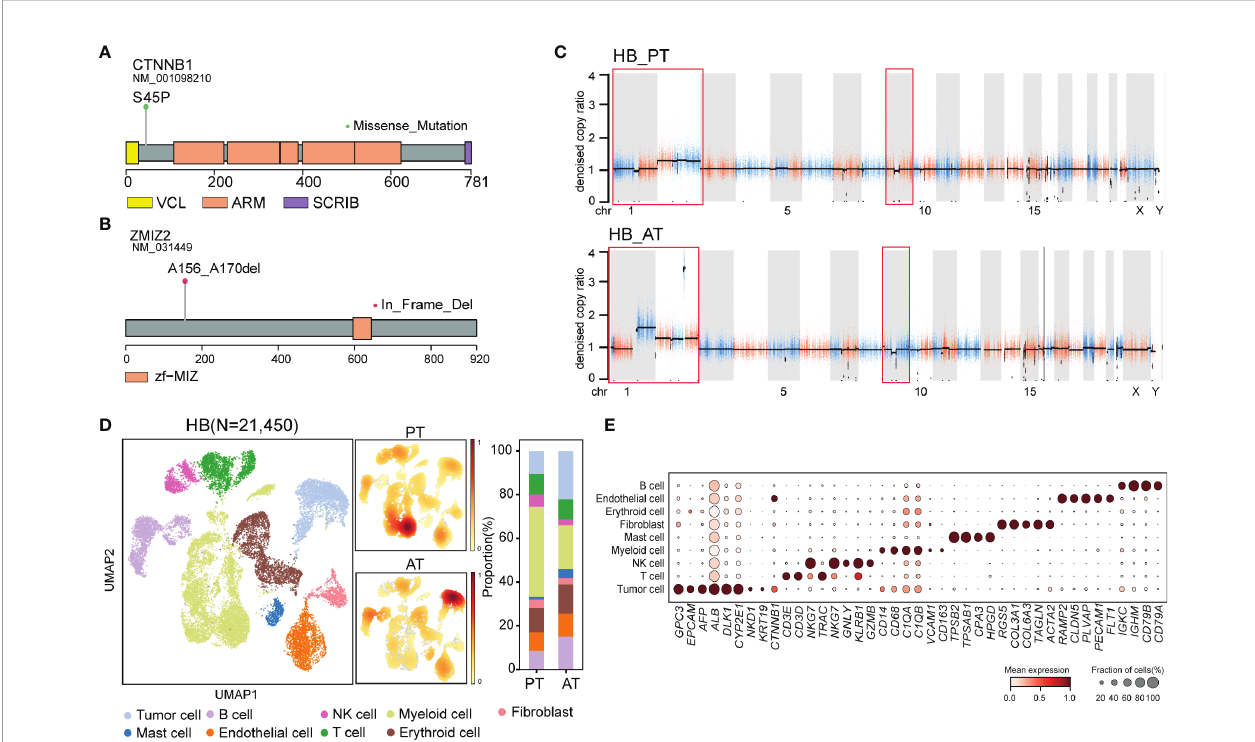
FIGURE 4 | The genomic and transcriptomic landscape of HB (A) Lollipop plot showing CTNNB1 p.S45P mutation. Boxes represented functional domains. VCL, interaction with VCL; ARM, Armadillo/beta-catenin-like repeats; SCRIB, interaction with SCRIB. (B) Lollipop plot showing ZMIZ2 in-frame deletion. Boxes represented functional domains. Zf-MIZ, Zinc fi nger MIZ domain. (C) Scatter plots showing copy number alterations in HB PT and AT samples. (D) UMAP visualization of 21,450 cells from HB colored by cell types (left) and density of sample distribution(middle). Right panel showing the percentage of different cell types in HB PT and AT samples. (E) Dot plot for expression of cell-type-speci fi c markers in HB. The color indicated scaled mean expression of marker genes, and the size indicated the proportion of cells expressing marker genes. HB, hepatoblastoma; PT, primary tumor; AT, tumor after